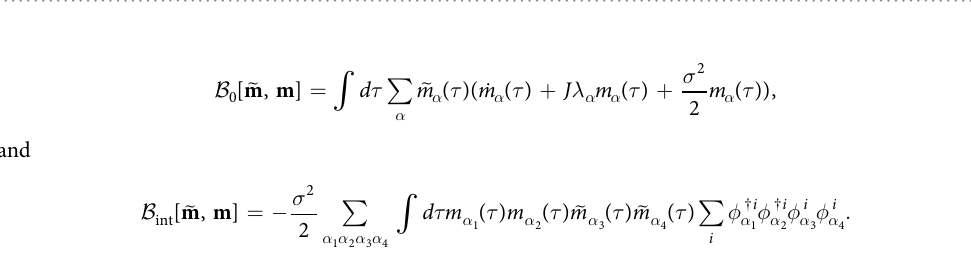
Figure 4. A diagrammatic representation of the second-order in perturbation theory Eq.